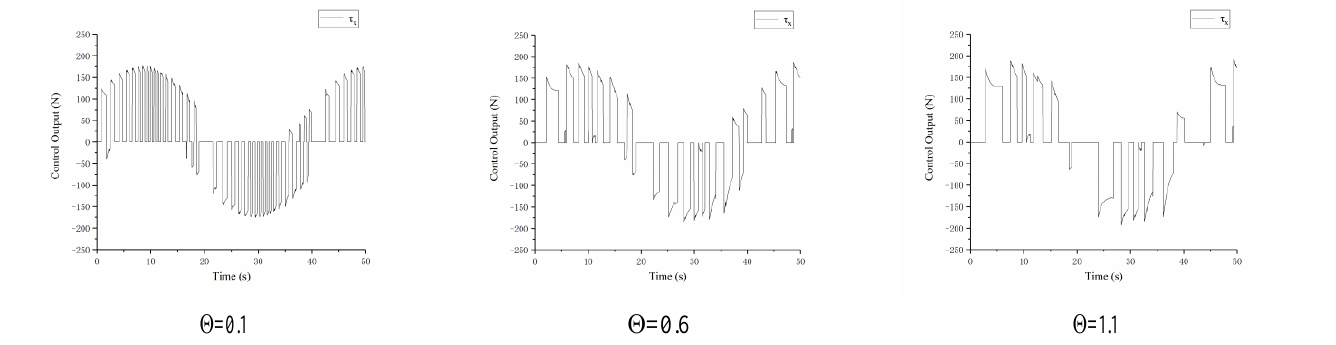
Figure 9. Control output of PRTC scheme.